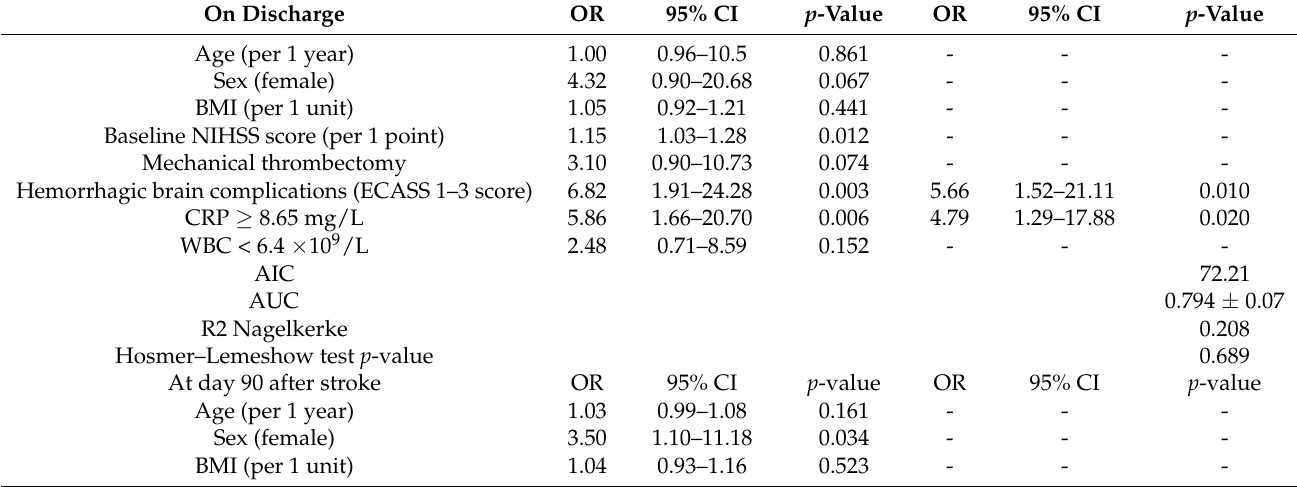
Table 3. Predictors of death on discharge and at day 90 after